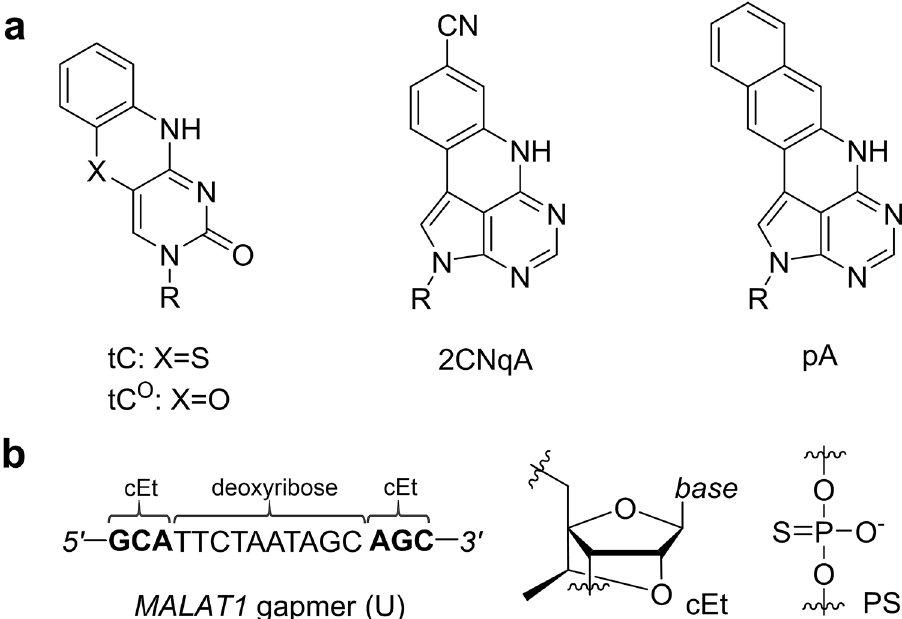
Figure 1. ( a ) Two fluorescent base analogues from the tricyclic cytosine family (tC and tC O ) and two adenine analogues (2CNqA and pA) were used in this study; R = deoxyribose. ( b ) Sequence and chemistry of the MALAT1 -targeting gapmer (U) explored in this study. The three flanking bases on each side (wings, bold font) have constrained ethyl (cEt) sugars, all other sugars are deoxyribose. The nucleotides in the gapmer are linked by phosphorothioate (PS)